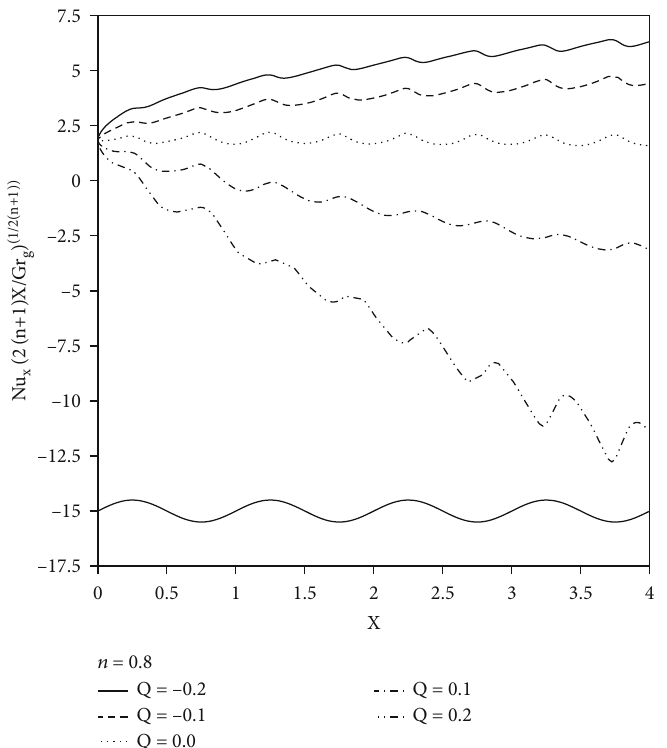
Figure 15: The axial distribution of the local Nusselt number for Pr